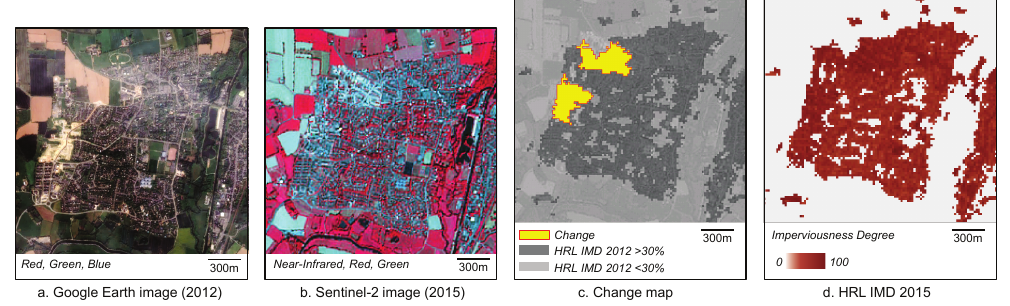
Figure 15. Detection of new subdivision in Rennes (yellow: changes; dark grey: HRL IMD 2010 >30%; light grey: HRL IMD 2012 <30%). ( a ) Google Earth image (2012); ( b ) Sentinel-2 image (2015); ( c ) Change map; ( d ) HRL IMD